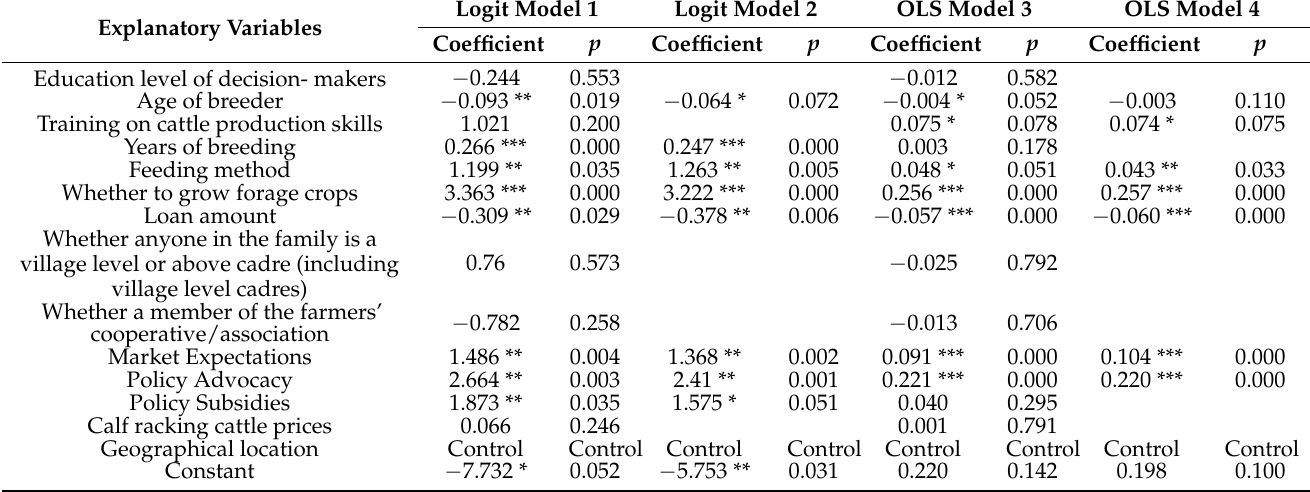
Table 3. Regression